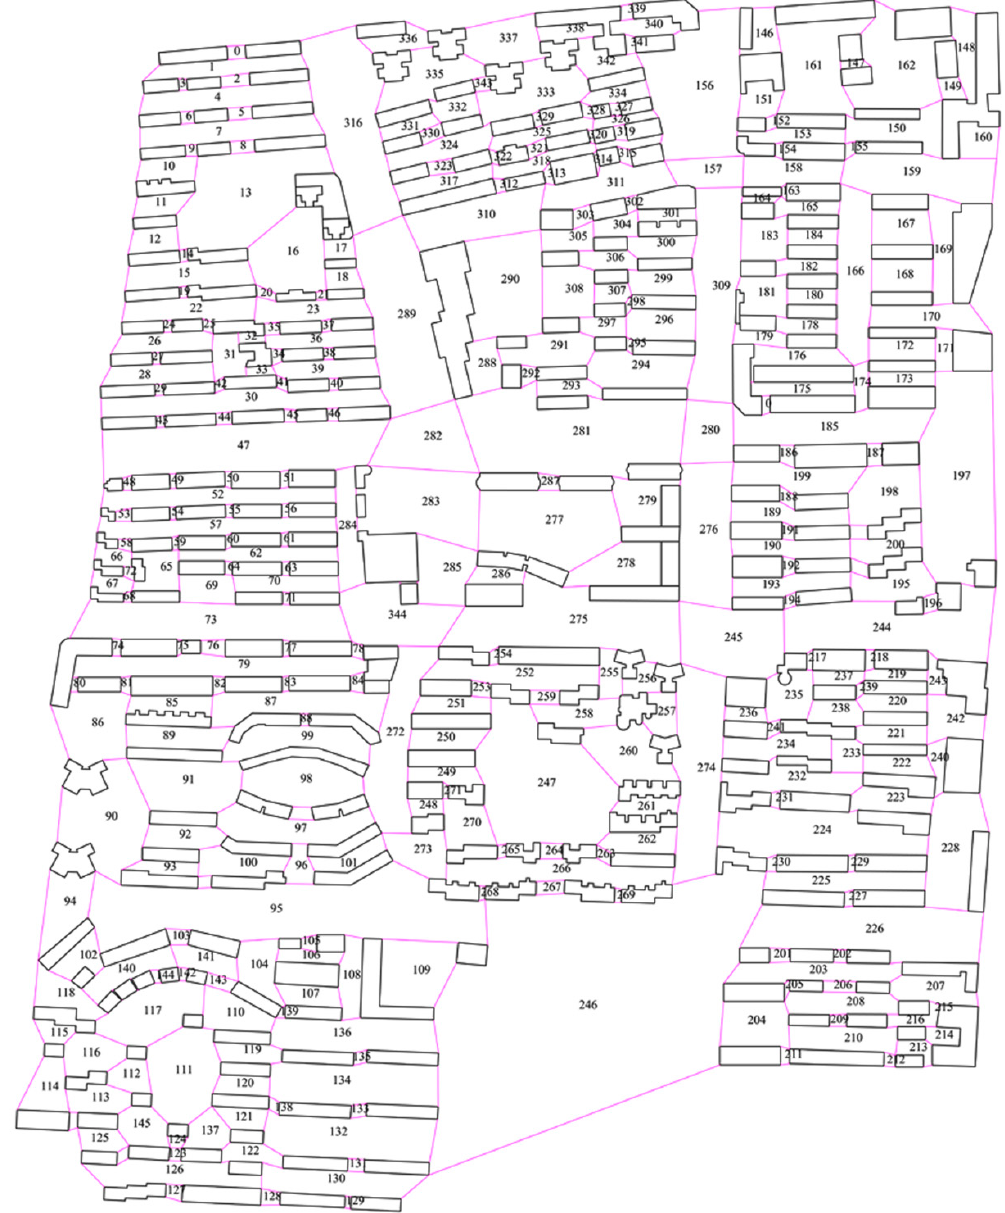
Figure 6. Spatial partition diagram of the study object. The black numbers are subspace numbers, the black lines are building boundaries, and the pink lines are spatial partition lines.